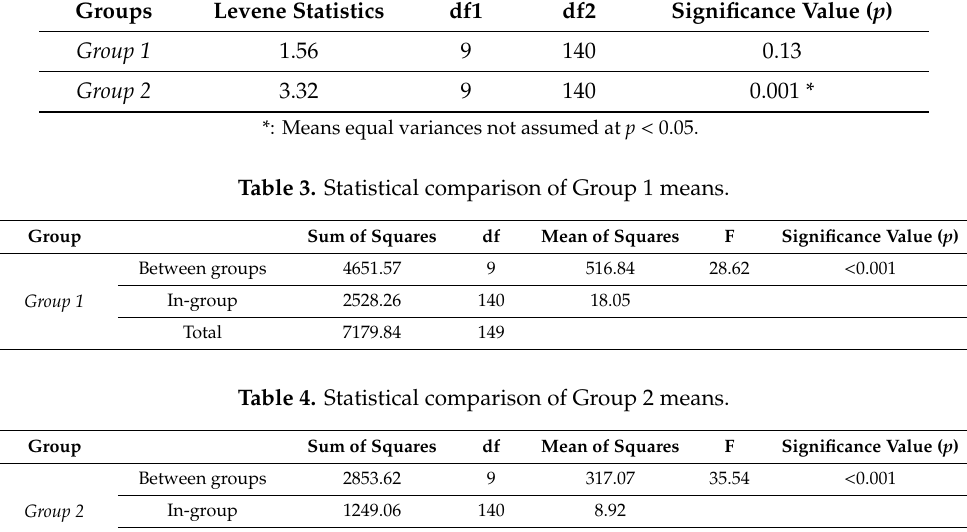
Table 2. Homogeneity test results of the groups.